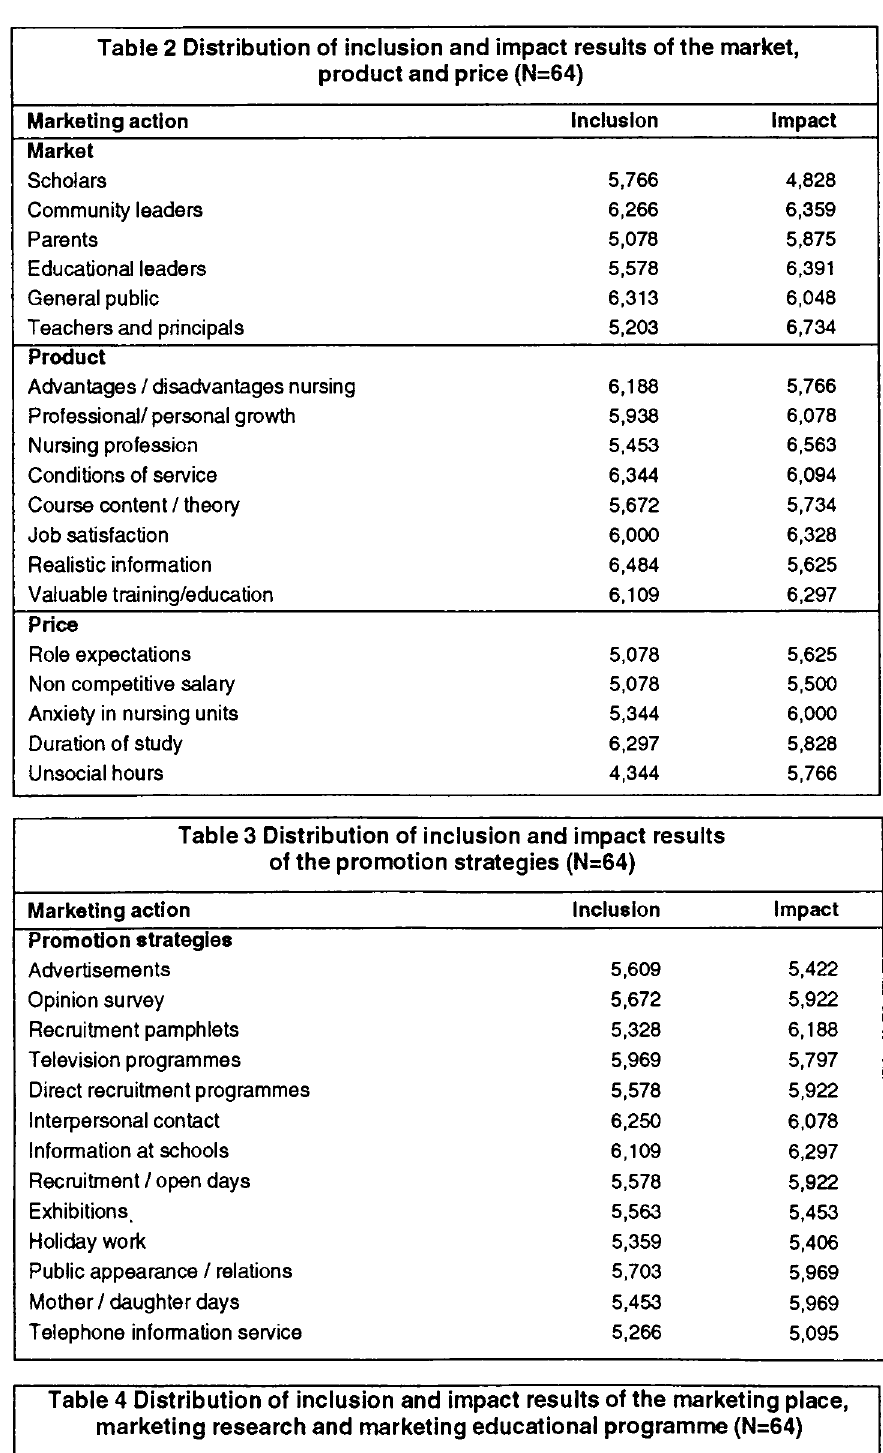
Table 4 Distribution of inclusion and impact results of the marketing